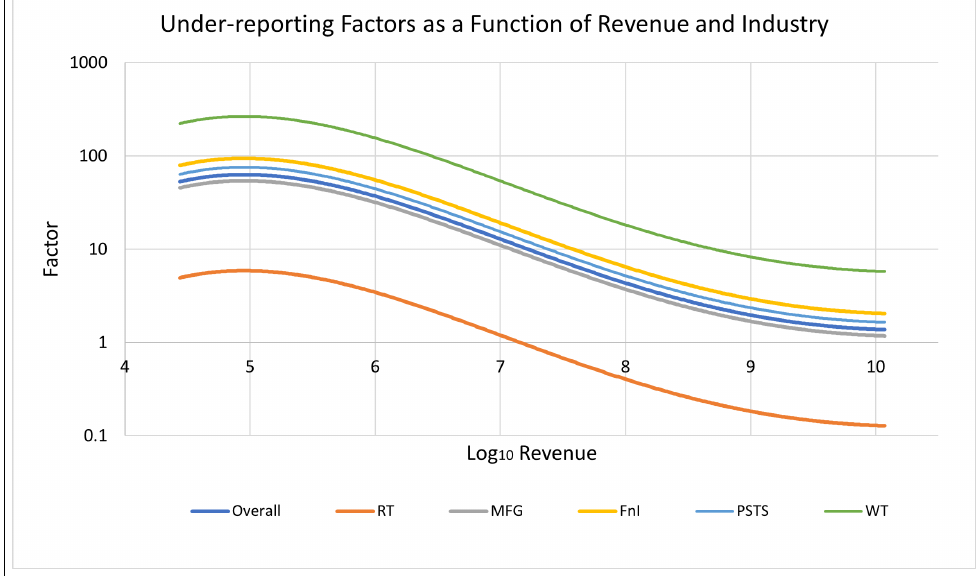
Figure 4. Under-reporting Factors as function of Revenue and